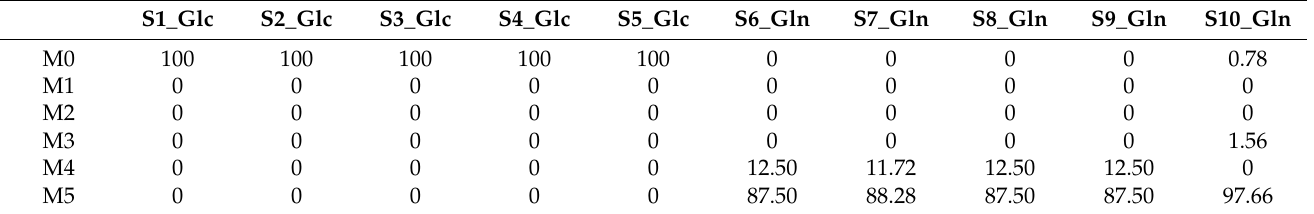
Table 1. Estimated corMID for Gln in 10 biological samples, either labeled for 24 h with [U- 13 C]Glc or supplied for 24 h with [U- 13 C]Gln (see column header). The average estimated fragment distribution used was [M+H] + = 38.1%, [M] + = 56.4%, [M-H] + = 5.5%, and [M+H 3 O − CH 4 ] + =